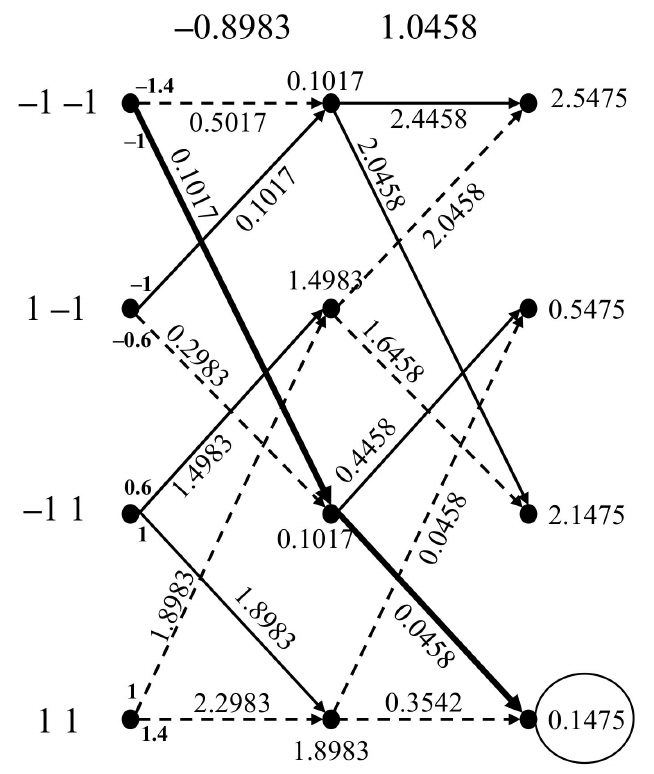
Figure 3. Trellis for the